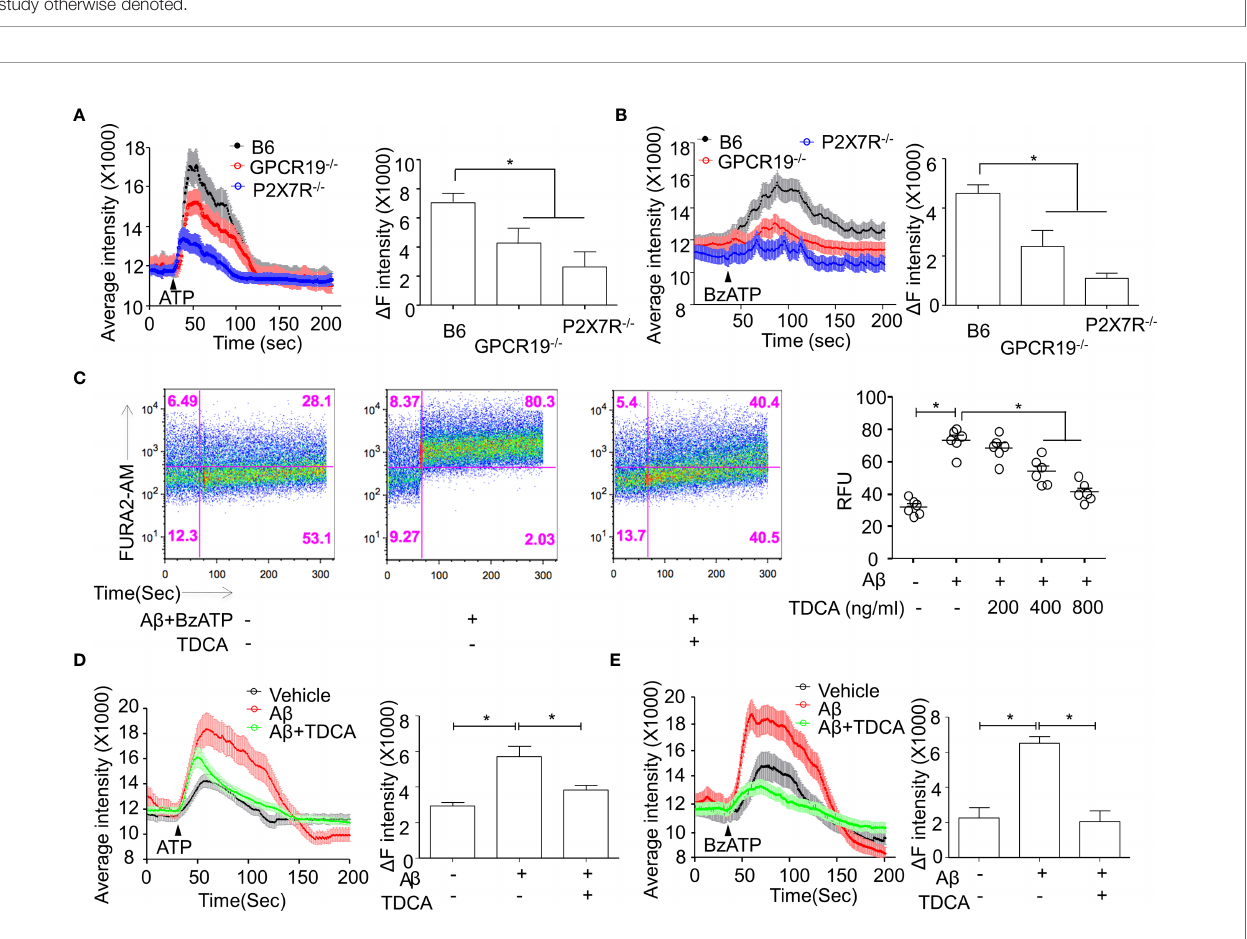
FIGURE 1 | GPCR19 and P2X7R are necessary for the inhibition of IL-1 b production in microglia by TDCA. (A) , A b ± ATP increased IL-1 b production of BV2 cells when measured by ELISA. (B) , Primary microglia were isolated from wild-type B6, P2X7R -/- , and GPCR19 -/- mice and were treated with A b , ATP, and TDCA. IL-1 b production by microglia was determined by ELISA. % Inhibition = (IL-1 b concentration without TDCA - IL-1 b concentration with TDCA)/(IL-1 b concentration without TDCA) x 100. (C) , Colocalization of GPCR19 and P2X7R on membranes of primary microglia was tested using confocal microscopy. (D) , Protein expression levels of GPCR19 or P2X7R in the frontal cortex were analyzed using western blotting. The expression levels in B6 mice were considered 100% (n=3). (E) , Human brain sections from patients with AD or patients without AD (non-AD, n=3) were stained with anti-GPCR19 Ab (green) and anti-P2X7R Ab (Red). Average of fi ve different ROIs (× 400) in each section were analyzed in the right panel. (F) , The expression levels of GPCR19 (green) and P2X7R (red) on the surface of BV2 cells were analyzed using confocal microscopy after treatment with A b , ATP, and TDCA for 1 (h) The areas of colocalization (yellow) of GPCR19 (green) and P2X7R (red) were calculated using ImageJ. (G) , Expression levels of GPCR19 and P2X7R in the frontal cortex of B6 (5xFAD -) or 5xFAD mice (5xFAD +) were analyzed using confocal microscopy after treatment with TDCA (1 mg/kg, i.p.) for 10 weeks. Colocalized areas of GPCR19 and P2X7R (yellow) were calculated using ImageJ. A b , ATP and TDCA were used at 2 µM, 1 mM and 400 ng/ml, respectively, throughout the study otherwise denoted. Data are from more than three independent experiments throughout the study otherwise denoted. The individual samples are shown with the mean ± SEM and * P < 0.05 using Student ’ s unpaired t -test throughout